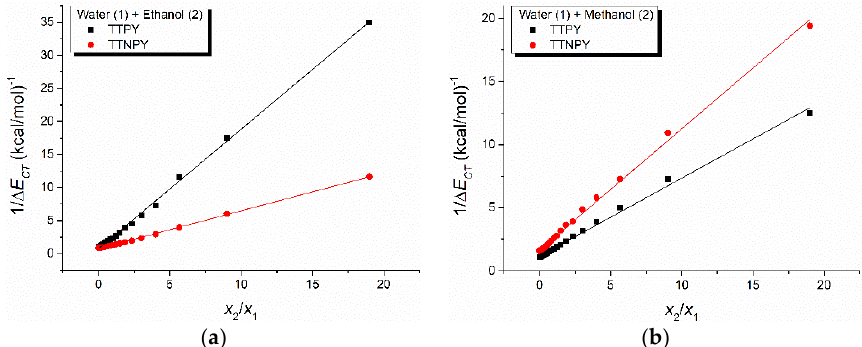
Figure 10. Inverse peak shift (measured against the peak corresponding to alcohols) of the 4-tolyl- 1,2,4-triazol-1-ium phenacylid (TTPY) and 4-tolyl-1,2,4-triazol-1-ium-4 ’ -nitro-phenacylid (TTNPY) absorption, respectively, versus the solvent bulk composition x 2 / x 1 , for the binary solvent mixtures water (1) + ethanol (2) ( a ) and water (1) + methanol (2) ( b ). Table 7. Results obtained through Suppan’s model.